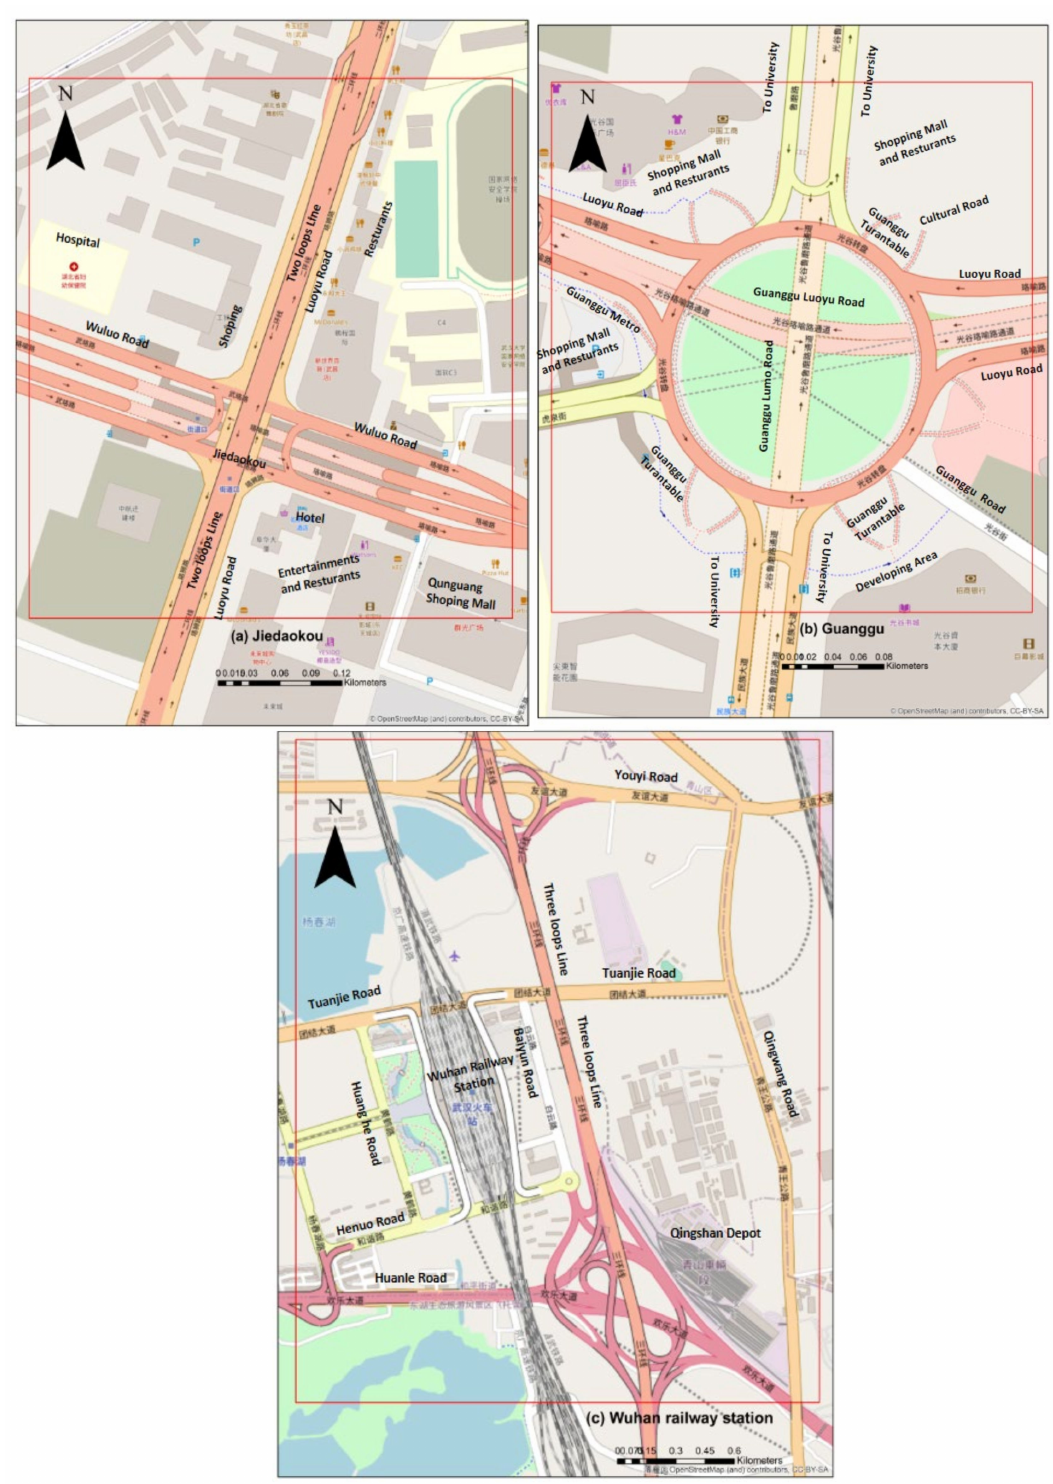
Figure 5. Three study areas in the city of Wuhan, ( a ) Jiedaokou area, ( b ) Guanggu area, ( c ) Wuhan railway station